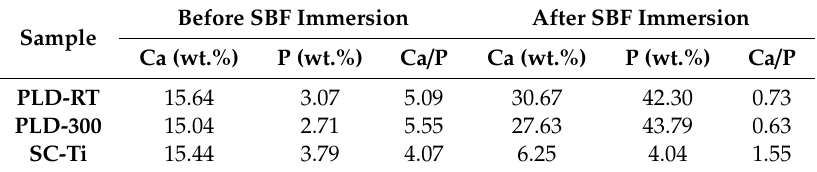
Figure 4. EDX spectra of: ( a ) target, ( b ) PLD-RT and PLD-300 thin films before SBF immersion, ( c ) SC-Ti thin film after SBF immersion for 28 days and ( d ) PLD-RT and PLD-300 thin films after SBF immersion for 28 days. Table 3. Ca / P ratios extracted from the EDX spectra before and after SBF immersion for 28